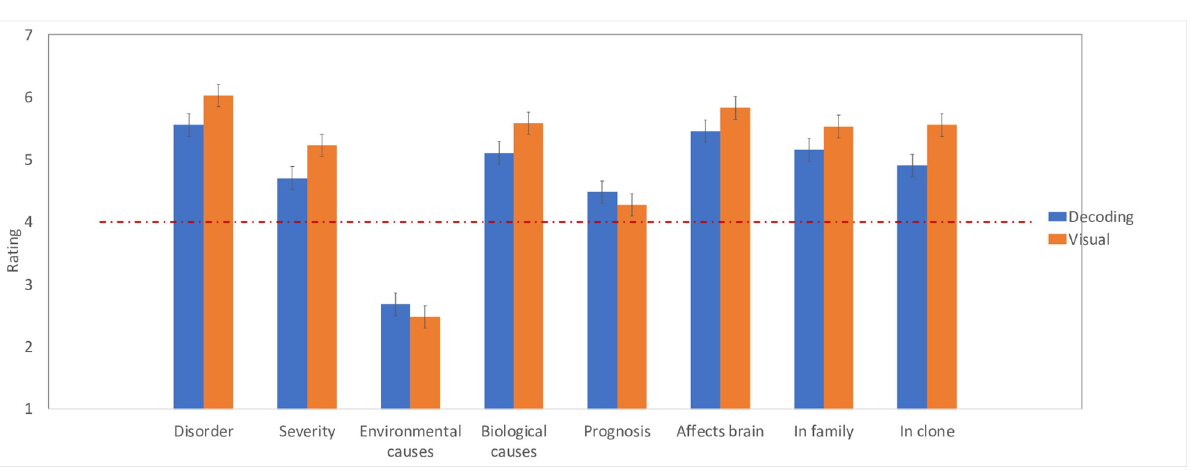
Fig 3. The evaluation of reading disorders associated with visual and decoding difficulties. Error bars in this and all subsequent figures are 95% confidence intervals for the difference between the means.